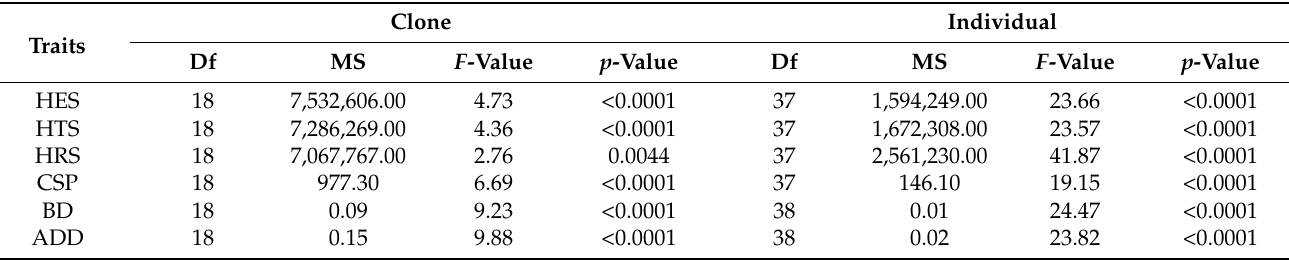
Table 3. Analysis of variance of wood properties.